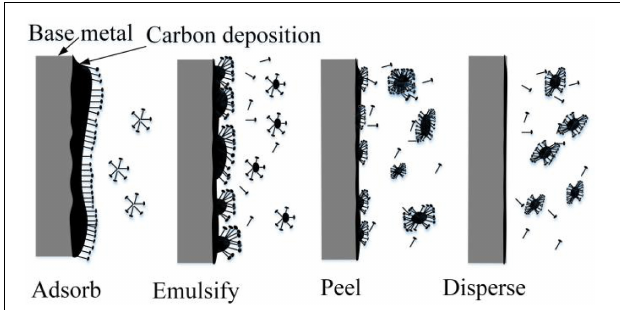
FIGURE 7 | Removing mechanism of CD detergent.